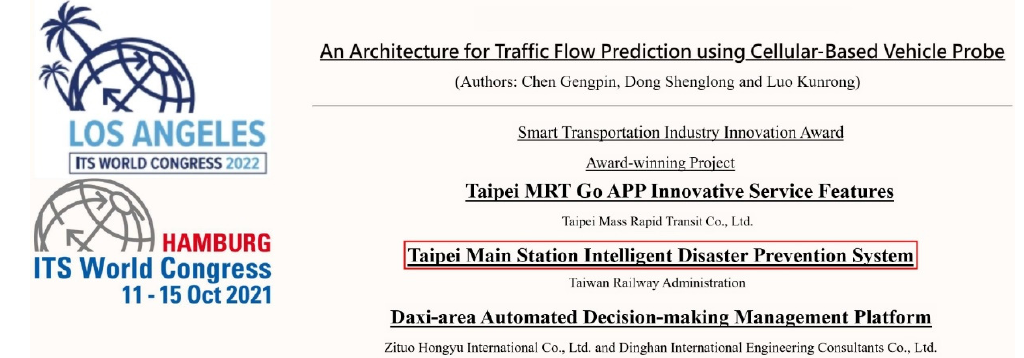
Figure 19. Smart Transportation Award of “Taipei Main Station Intelligent Disaster Prevention System” (Source: Taipei Main Station Intelligent Joint Disaster Prevention Center, 2020).